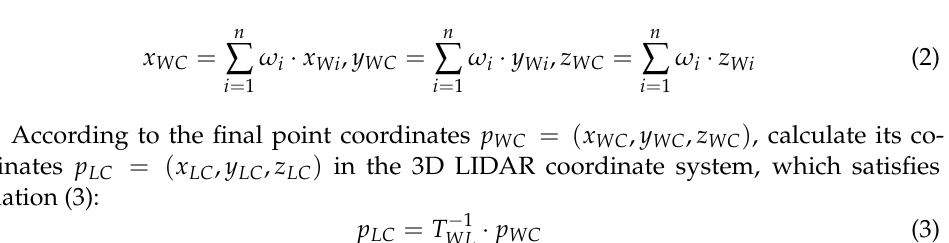
Figure 5. Coordinate system transformation diagram.